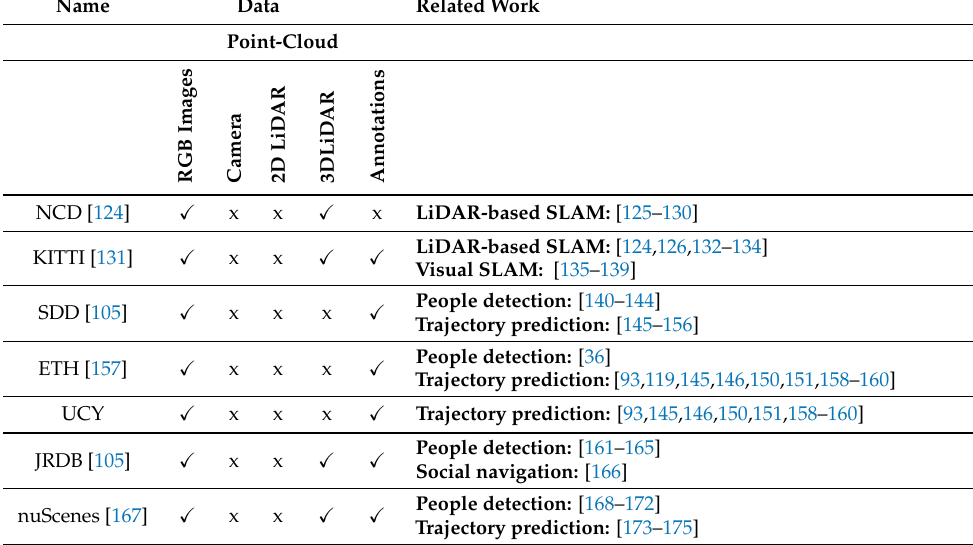
Table 7. Relevant datasets to test methods related to social